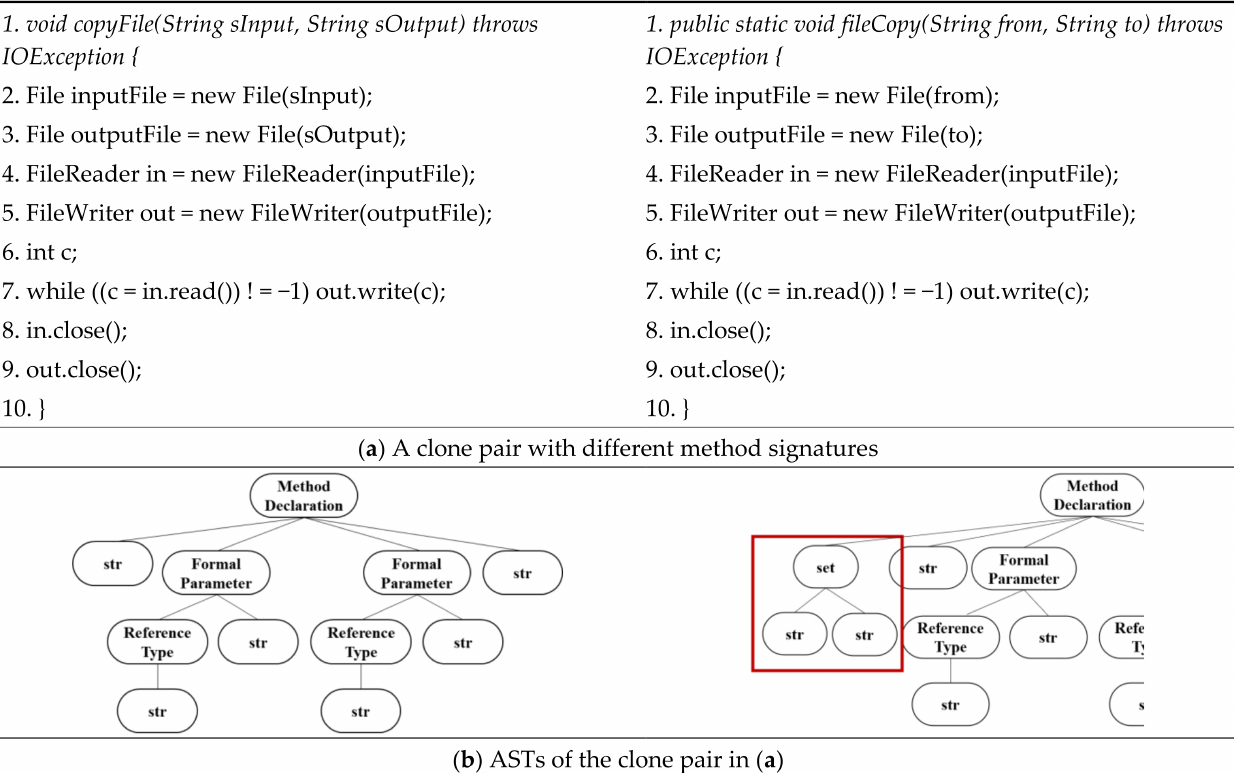
Figure 5. Example of ST3 clone classified as T2